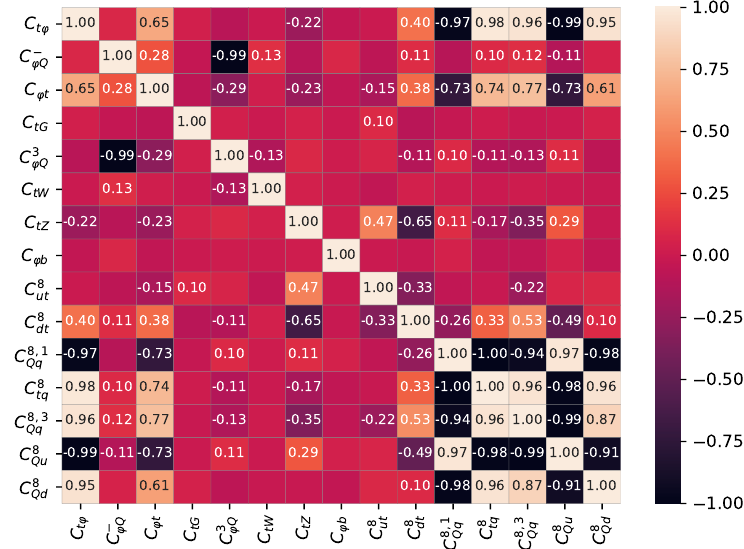
Figure 10 . Correlation matrix between the different EFT operators obtained in the linear (Λ − 2 ) “4F” robustness test fit described in section 8.2. Cells are filled if the correlation is higher than 10% in absolute value. The operator O ϕb , that modifies only the bottom quark electro-weak couplings, is taken into account in the fit but limits on its coefficients are not reported since the obtained values are not competitive using only the observables considered in our